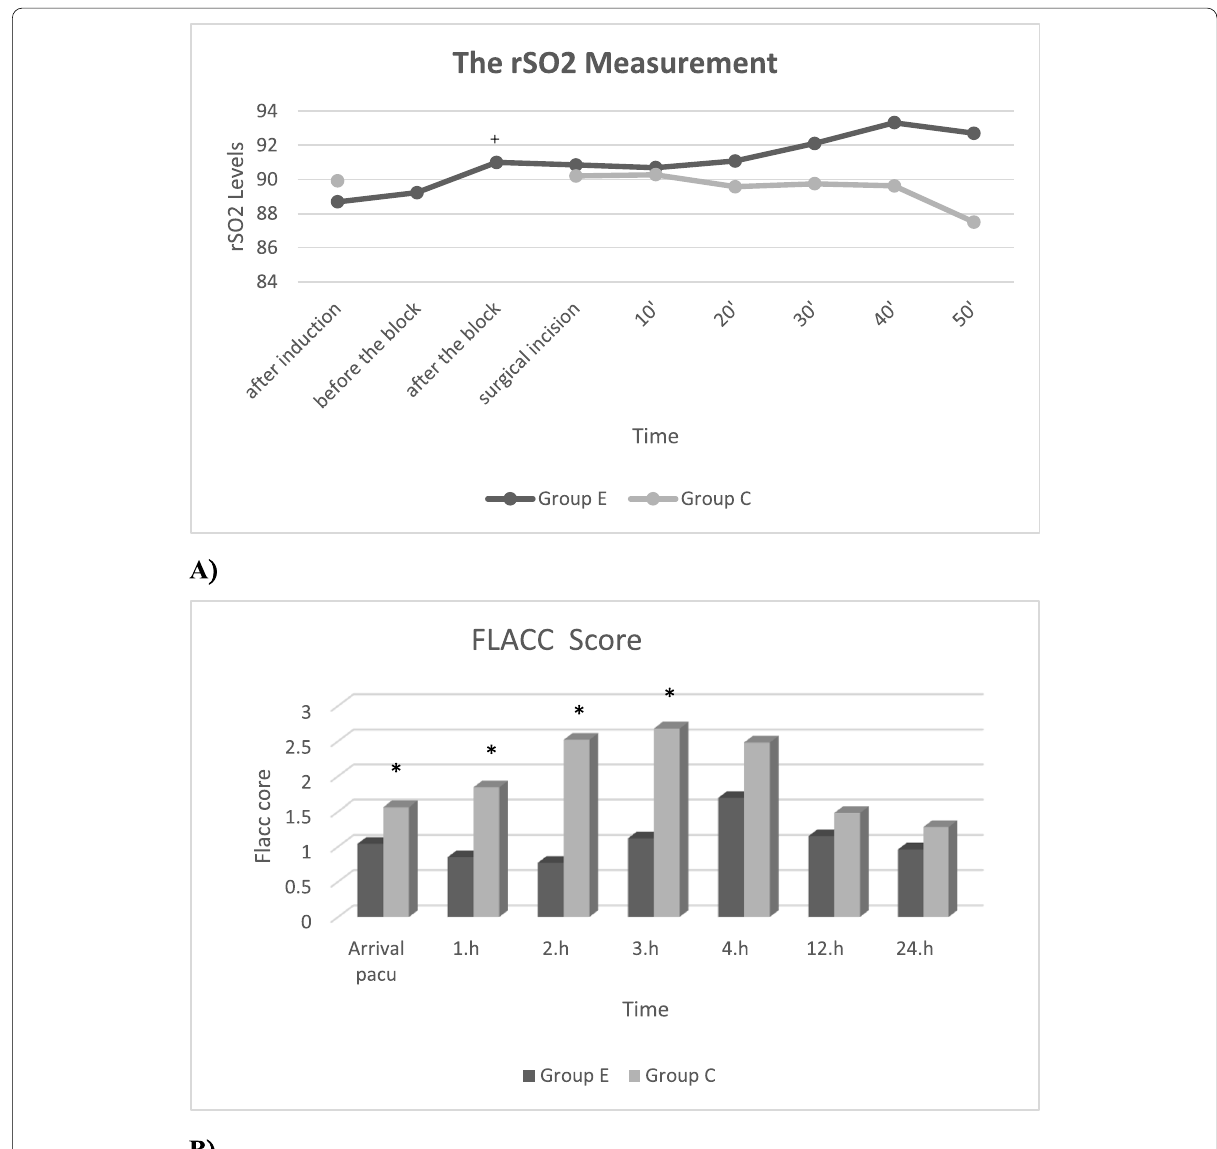
Fig. 3 Changes in intraoperative SO 2 and postoperative FLACC in groups. Values of intraoperative rSO 2 levels. * p: Comparison of intragroup. B FLACC in the studied groups. Values are presented as